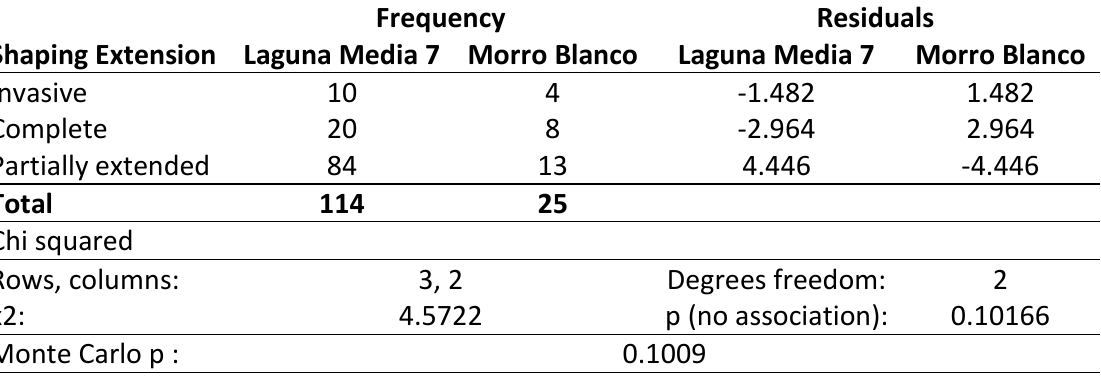
Table 6. Frequencies and normalized residuals for the shaping extension in the tools from Laguna Media 7 and Morro Blanco - x 2 and Monte Carlo